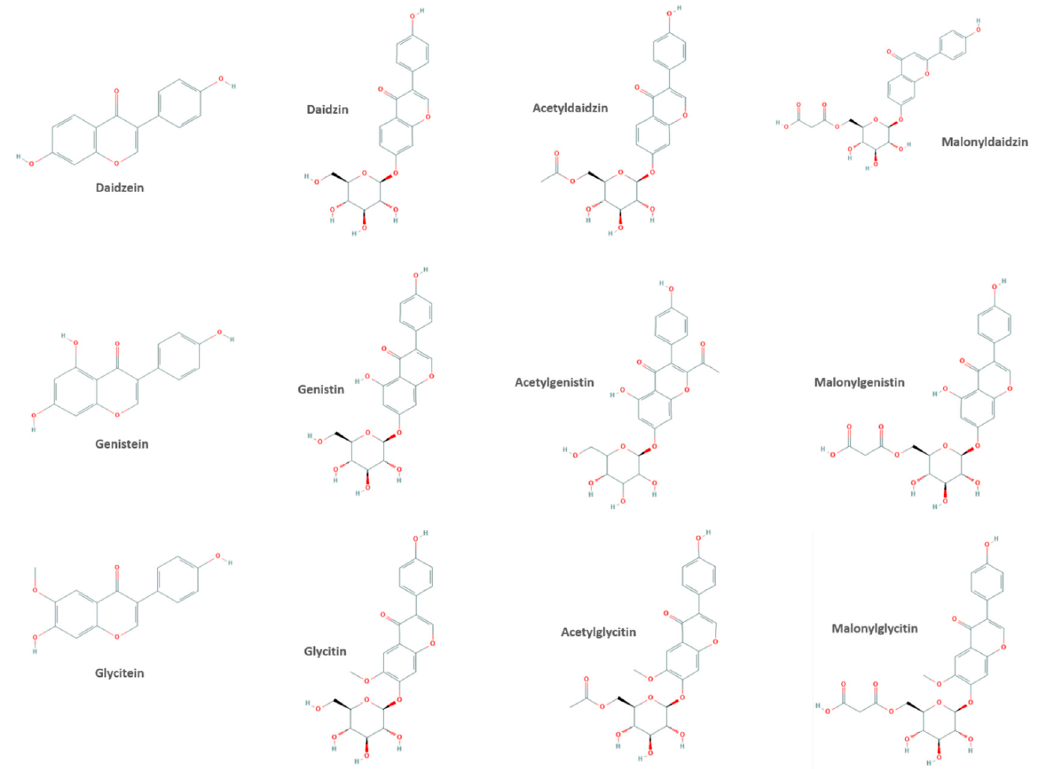
Figure 2. The four chemical forms of the three most abundant isoflavones.